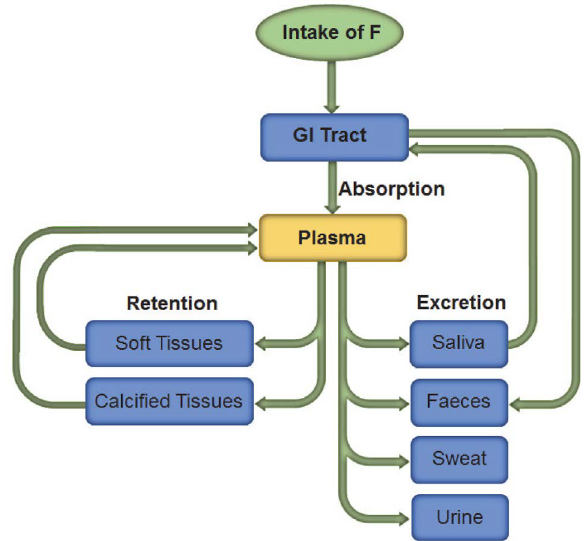
Figure 2: General features of fluoride